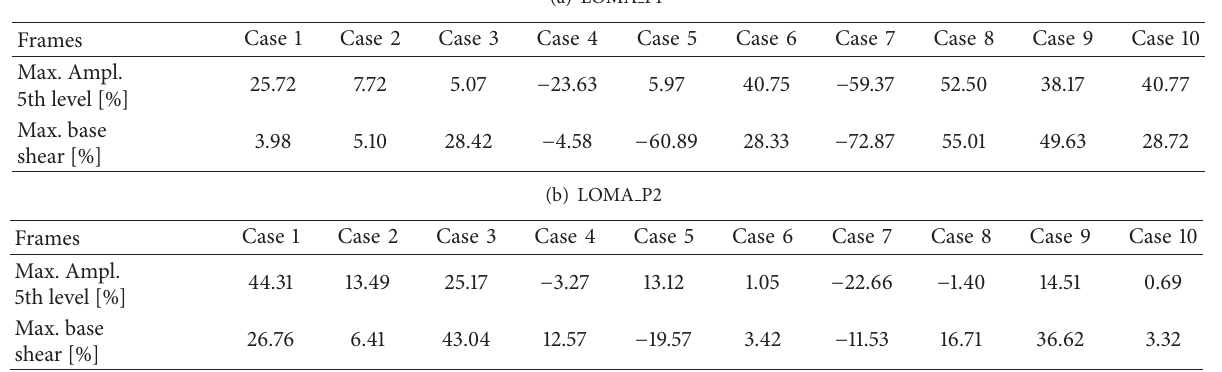
Table 2: Reduction obtained in protected frames with respect to braced